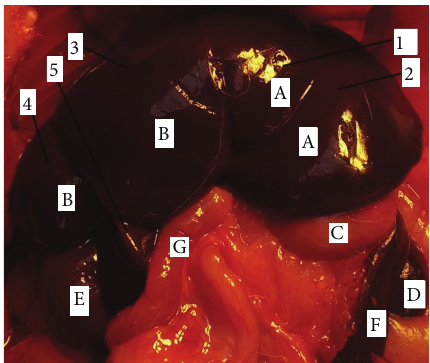
Figure 3: Morphology of rat liver ( facies diaphragmatica ). 1: lobus hepatis sinister medialis , 2: lobus hepatis sinister lateralis , 3: lobus hepatis dexter medialis , 4: lobus hepatis dexter lateralis , 5: lobus quadratus , A: lobus hepatis sinister , B: lobus hepatis dexter ,